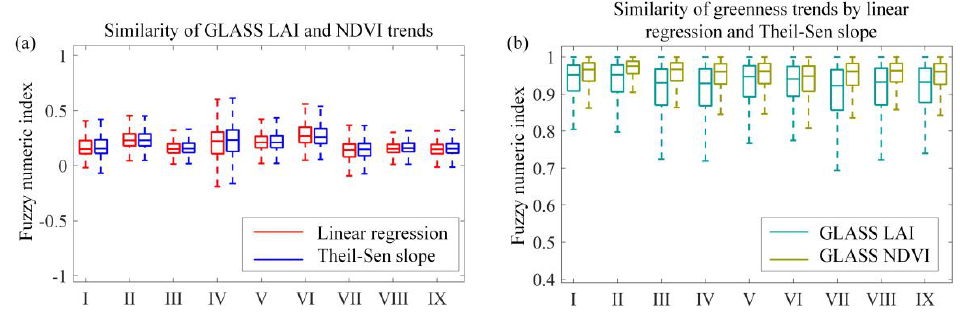
Figure 6. Boxplots of fuzzy numerical maps between trends from ( a ) di ff erent datasets and ( b ) trends detected by di ff erent algorithms.